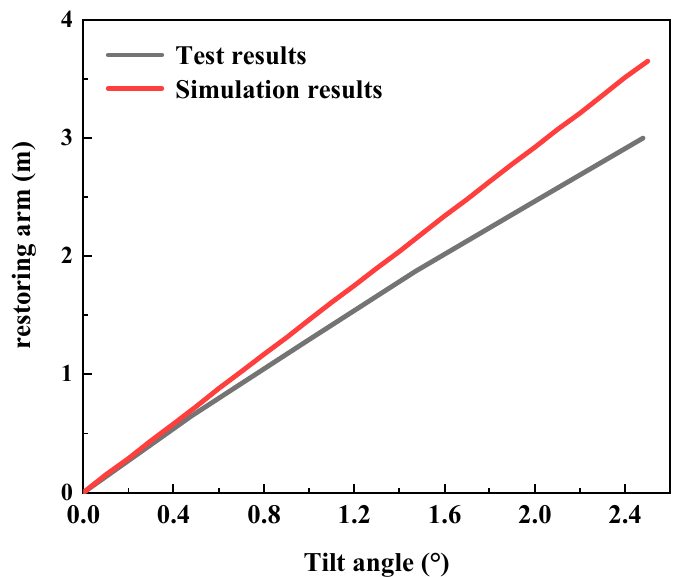
Figure 14. Comparison of test and simulation of restoring arm.